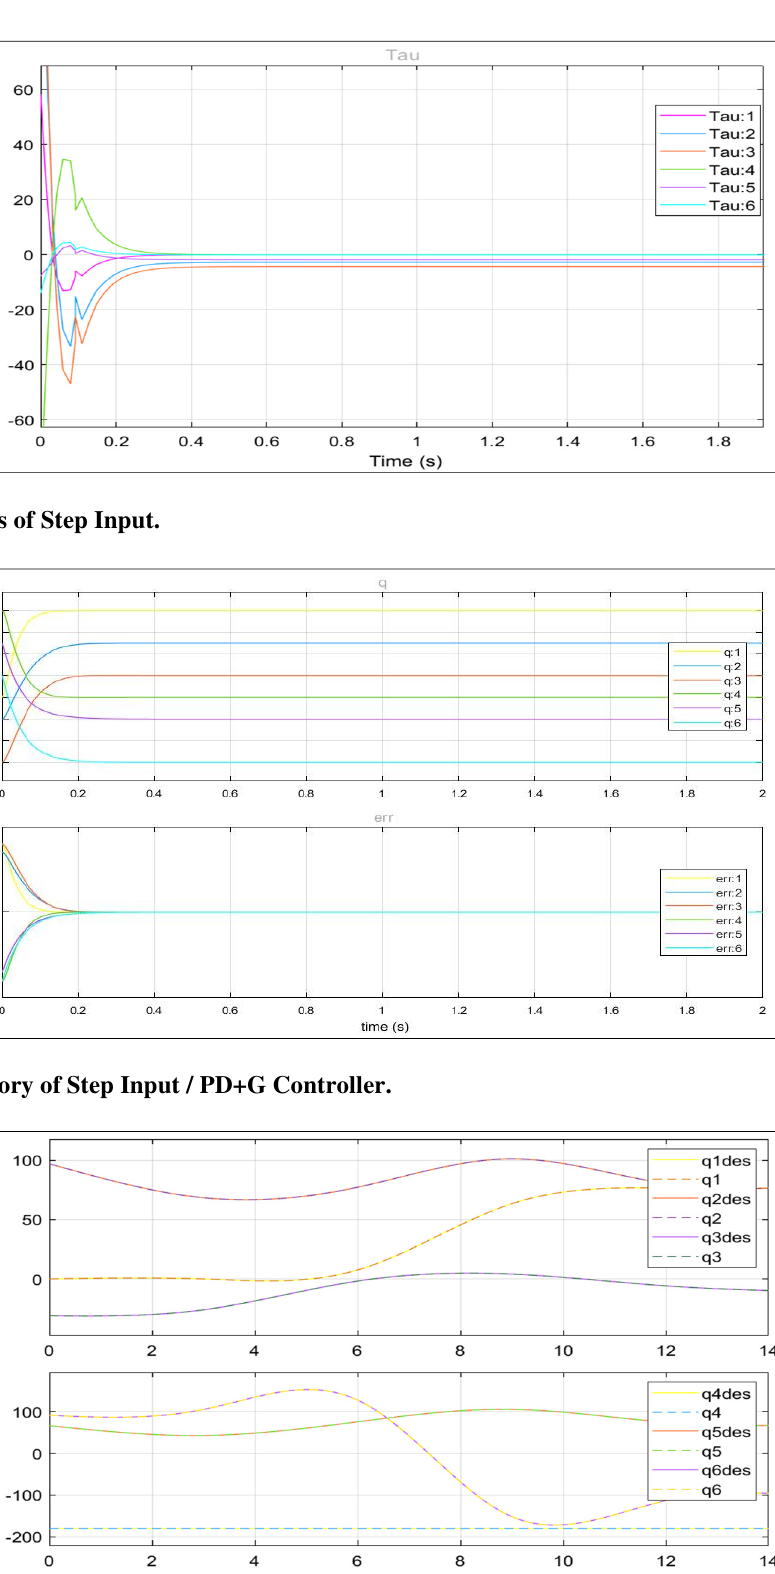
Fig. 12. Joint Space Tracking Trajectory/